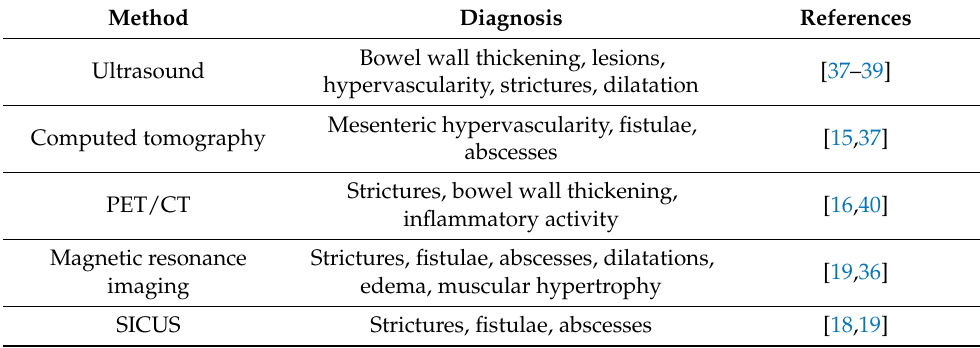
Table 1. Diagnostic imaging methods to detect inflammation and complications in